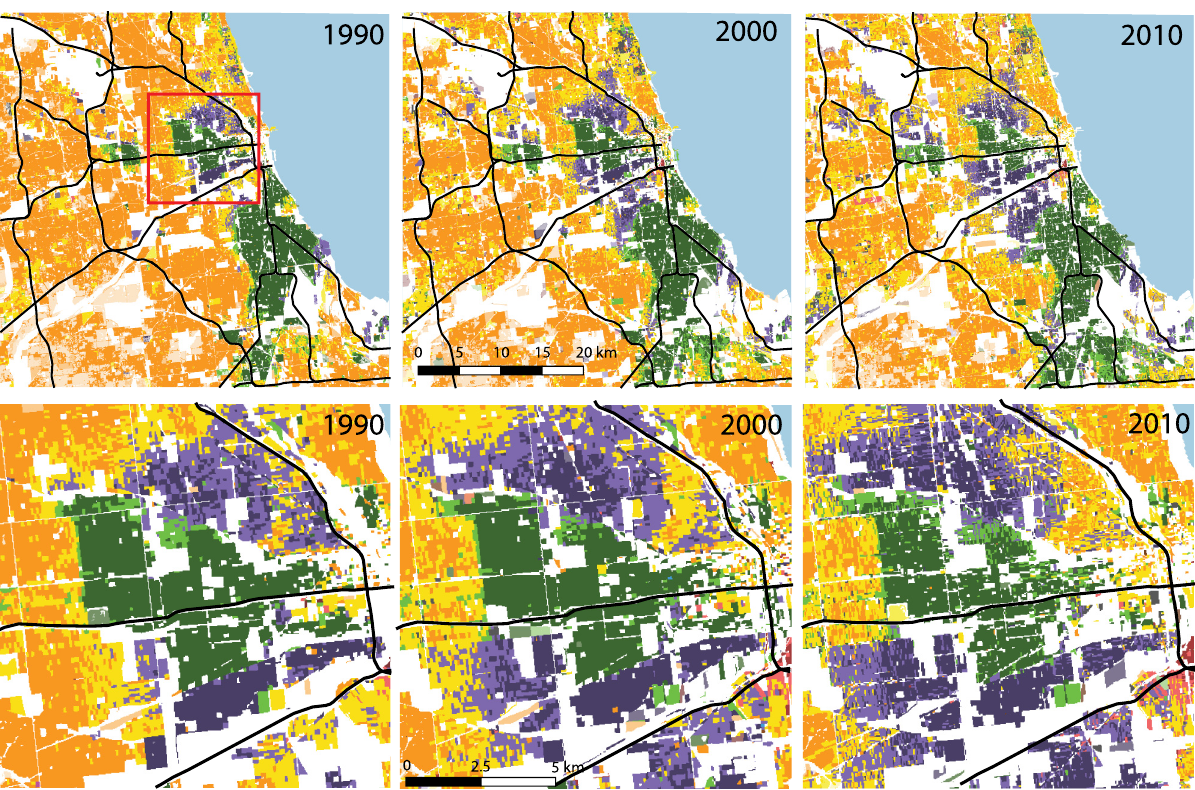
Fig 3. Racial diversity maps of the Chicago area for 1990, 2000, and 2010. The upper row shows maps for the greater Chicagoarea and the lower row shows maps for the central Chicagoarea indicatedby a red rectangle on the broaderextent map for 1990. Major roads are overlaidfor geographical reference. For the legendof community categories see Fig 2, the white color indicatesuninhabitedareas.